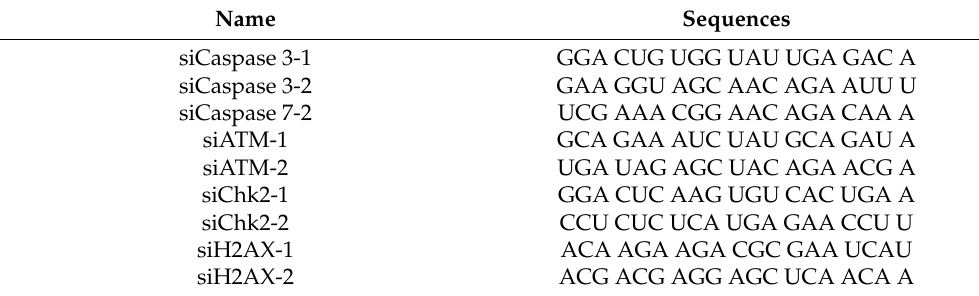
Table 2. The sequences of siRNA were used in this